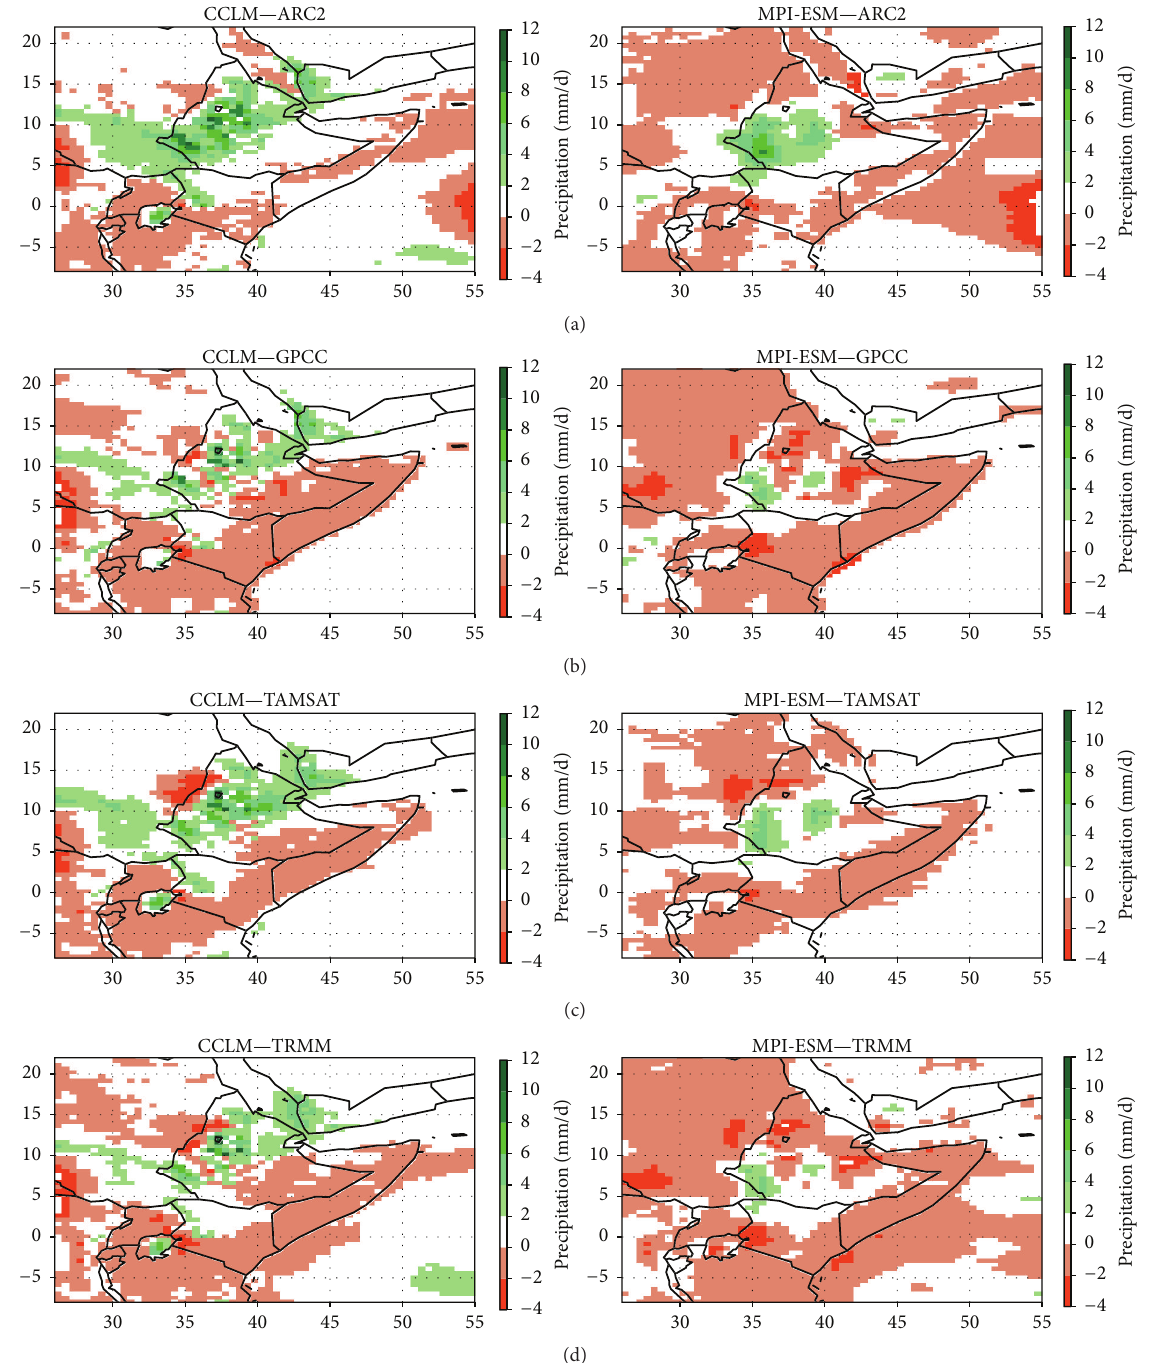
Figure 3: Spatial bias of JJAS average daily precipitation for COSMO-CLM (first row) and MPI-ESM (second row) from top to down with respect to ARC2, GPCC, TAMSAT, and